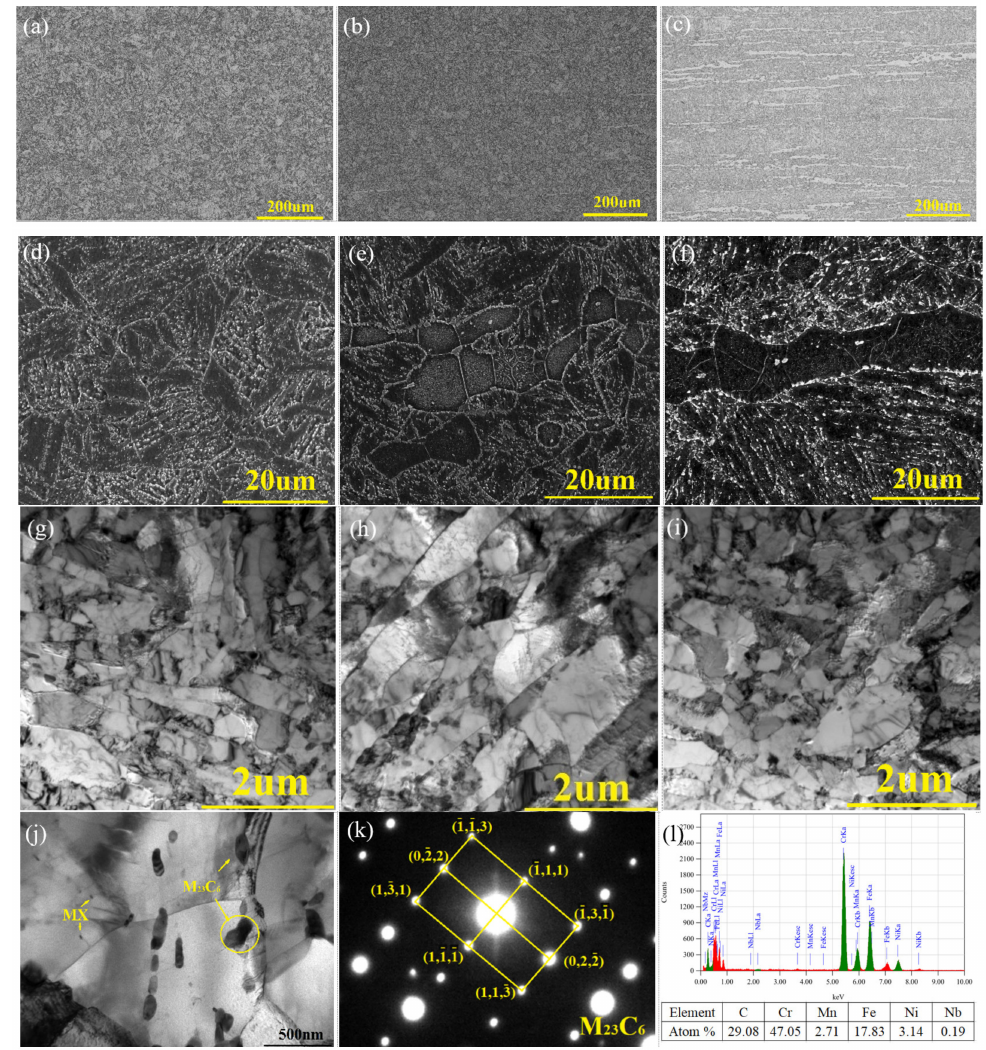
Figure 3. Microstructure of three steels: ( a ) T91LSi OM; ( b ) T91MSi OM; ( c ) T91HSi OM; ( d ) T91LSi SEM; ( e ) T91MSi SEM; ( f ) T91HSi SEM; ( g ) T91LSi TEM × 20,000; ( h ) T91MSi TEM × 20,000; ( i ) T91HSi TEM × 20,000; ( j ) T91MSi TEM × 50,000; ( k ) SAED result for mark points in image “ j